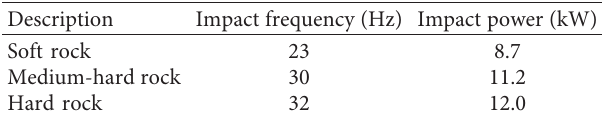
Figure 4: Impact performance of a DTH hammer for different rock types: (a) piston displacement for maximum penetration and (b) piston displacement with time. Table 1: Numerical simulation results of a DTH hammer according to rock type.